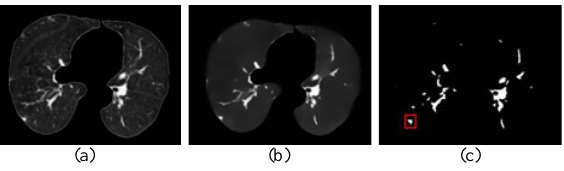
Fig. 8. Result of the suspected adhesive lung nodules segmentation. (a)original image, (b)NAD filtering enhancing, (c)the proposed method.